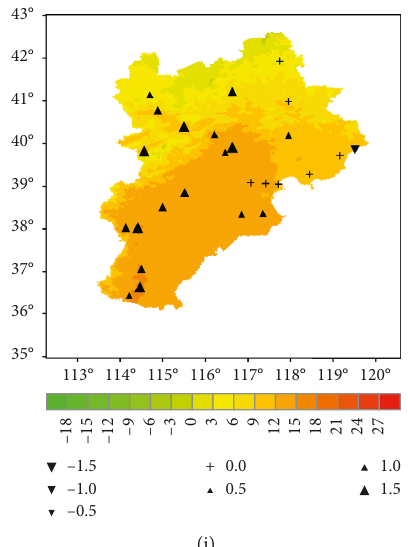
Figure 2: Distribution of the bias in the seasonal mean and annual mean temperature in the WRF simulation and HASM fusion compared to the observations in 1956–2005. denotes warm bias. denotes cool bias. (a) HASM-spring; (b) WRF-spring; (c) HASM-summer; (d) WRF-summer; (e) HASM-autumn; (f) WRF-autumn; (g) HASM-winter; (h) WRF-winter; (i) HASM-annual; (j) WRF-annual. ▲ ▼ Table 1: Mean absolute error (MAE) values of the WRF model and HASM.